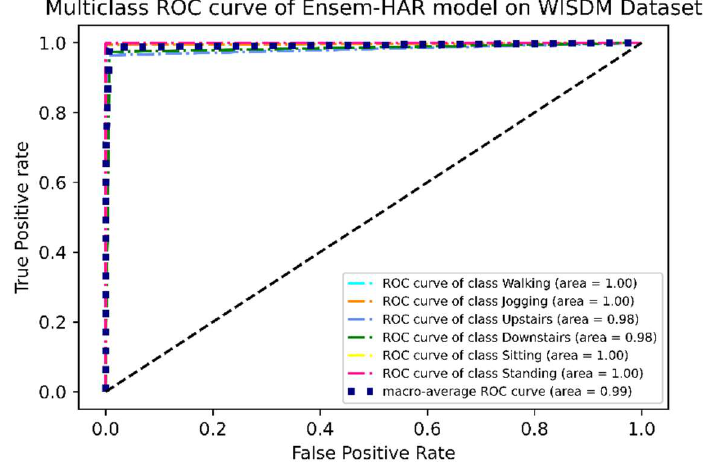
Figure 13. ROC curve (one vs. rest) of the proposed Ensem-HAR model on the WISDM dataset.